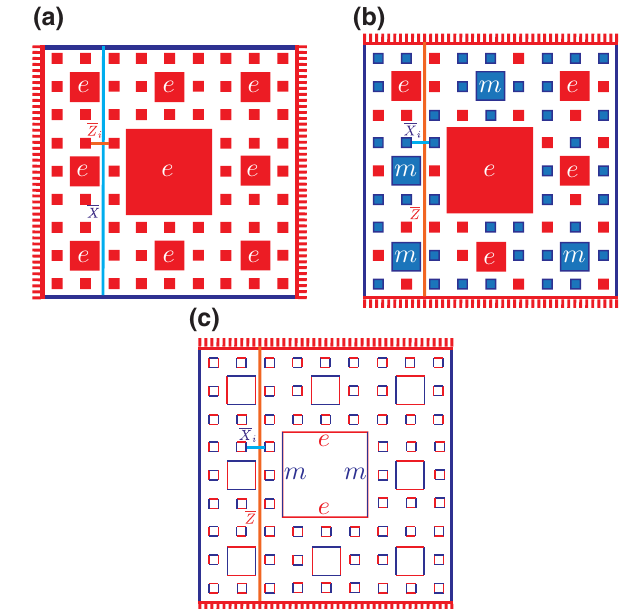
FIG. 6. (a) The exponential suppression of the ground-state degeneracy under a perturbation in the Hamiltonian of the con- ventional surface code defined on SC ( 3, 1, l = 0 ) . (b) On the Sierpi´nski-carpet model defined on SC ( 3, 1, l → ∞ ) , a perturba- tion in the Hamiltonian can lead to the splitting of the extensive ground-state degeneracy at a scale comparable to the gap.